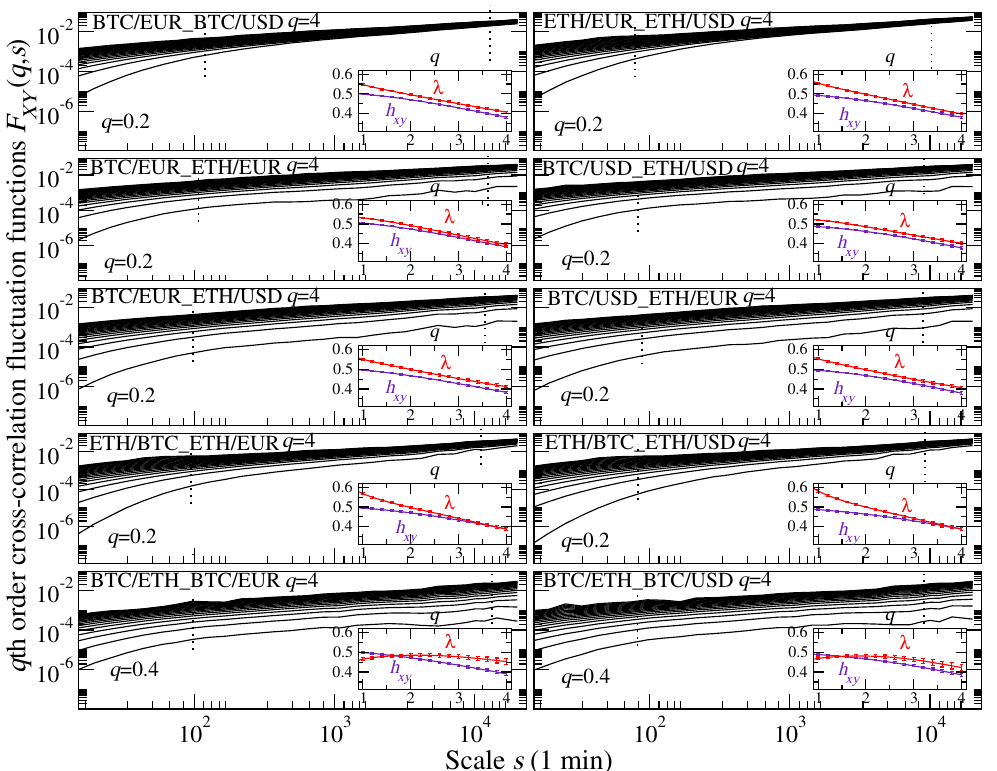
Figure 8. Family of the q th-order fluctuation cross-covariance functions F XY ( q , s ) , for different values of q in steps of 0.2, and calculated for the cross-correlations among the BTC/EUR, BTC/USD, ETH/EUR, ETH/USD, BTC/ETH and EUR/USD exchange rates. The upper-most lines correspond to q = 4, whereas the bottom ones to those for which F XY ( q , s ) are still positive. Insets illustrate the resulting q -dependence of λ ( q ) versus the average of the generalized Hurst exponents h xy ( q ) = ( h x ( q ) + h y ( q )) /2 of the two series x ( i ) and y ( i ) under